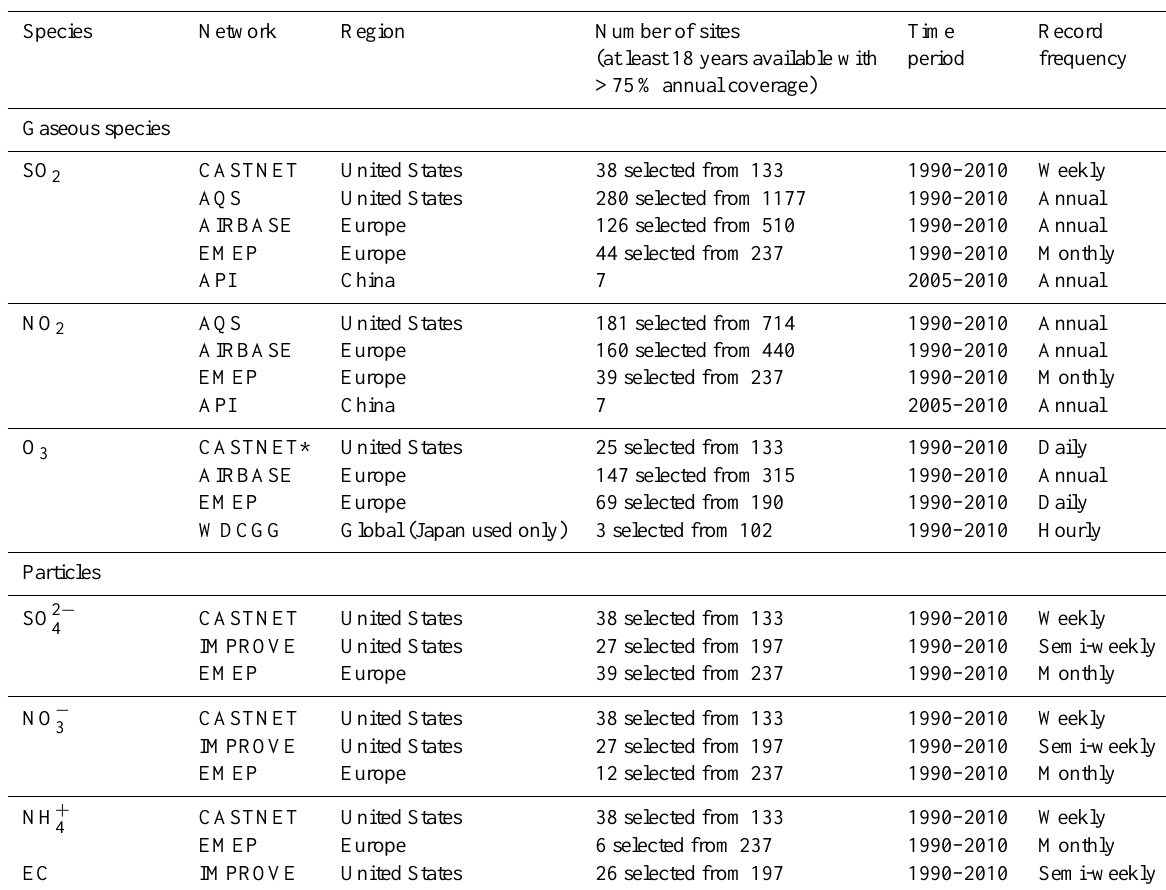
Table 1. Summary of long-term observations used for trends analysis in this study.